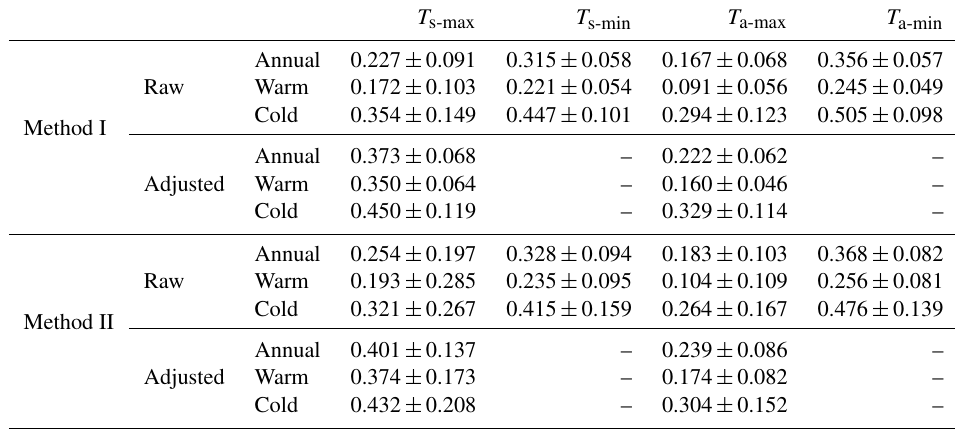
Table 1. Warming rates (unit: ◦ C 10yr − 1 ) of the temperatures ( T s-max , T s-min , T a-max , T a-min ) for the annual, warm and cold seasonal scales. “Raw” and “Adjusted” represent the warming rates calculated for the data before and after adjusting for the effect of surface solar radiation ( R s ) and precipitation ( P) , respectively. In Method I, the national mean anomalies were calculated first and then the national mean trend based on this time series was calculated. In Method II, the trend of each grid was calculated first and then the national mean value of the trends of all grids was calculated using the area-weight average method. We calculated the national mean trends of the temperatures using both methods.